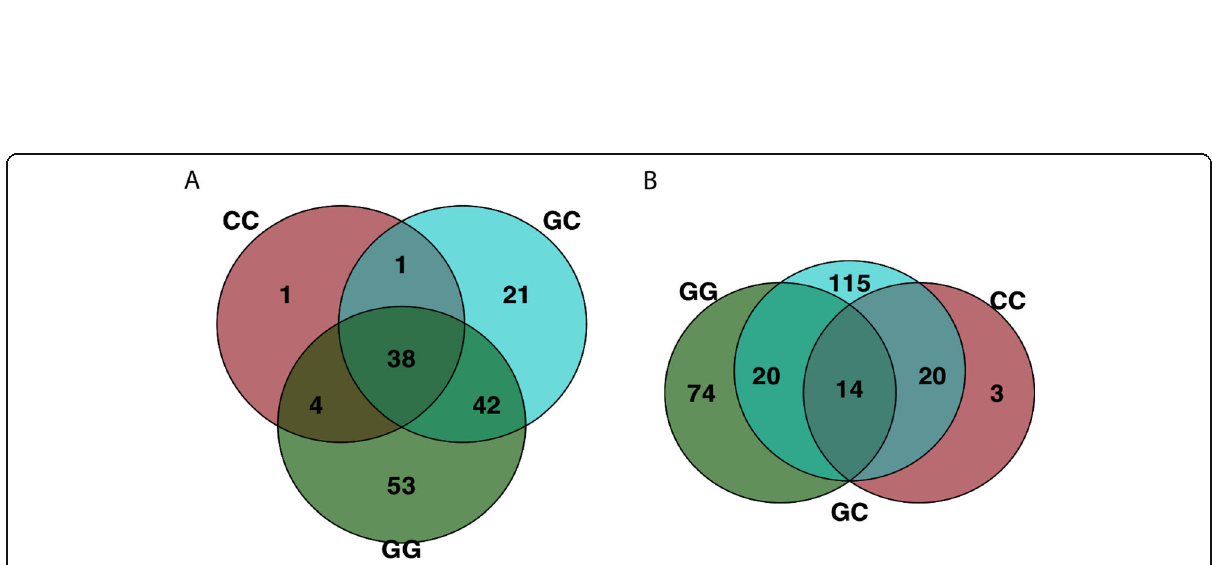
Fig. 5 Core OTUs shared by 90% of samples from a ) larval fish skin and b ) tank water microbial communities in each treatment on day 15. On day 15, three true treatments were